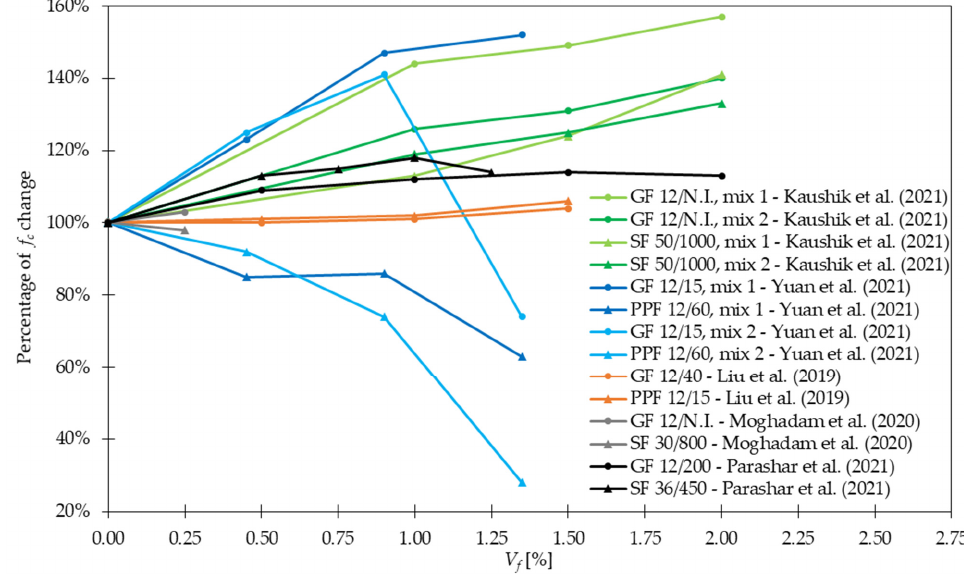
Figure 9. Change of f c in relation to V f for different fiber material and geometry l f /d f [19,23,26,33,53].